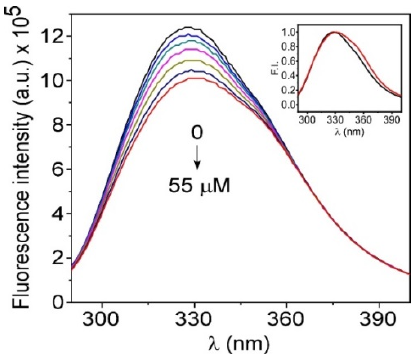
Figure 5. Fluorescence emission spectra of AGP (6.2 μ M) ( λ exc = 280 nm) in water at 25 °C, with increasing concentrations of TMZ. Inset: Normalized emission spectra of AGP in the absence (black) and the presence (red) of TMZ (55 μ M).